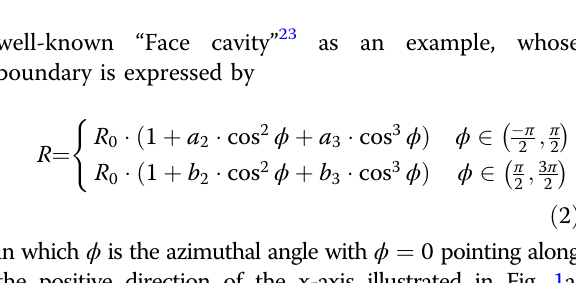
Fig. 1 Ray dynamics of topologically curved microcavities. a Schematic picture of the microcavity. O and O ’ are the center of the spherical surface and the geometric center of the cavity, respectively. ROC: radius of curvature; ROB: radius of the boundary. b Light trajectories of a symmetric circular cavity with ROB = 0.8 de fi ned on a curved surface of ROC = 1. c sin χ ( χ is the re fl ecting angle) of the N-period modes as a function of the effective curvature k = ROB/ROC in a symmetric circular microcavity. d Calculated resonant frequencies for the 3-period (red) and 4-period (blue) modes as a function of k in a symmetric circular microcavity. e , f The PSOS of a Face cavity de fi ned on a curved surface with k = π /6 ( e ) and on a fl at surface ( f ). The dashed horizontal lines label the bottoms of the higher islands in the 3-period and the 4-period groups, which correspond to identical structural positions in the PSOSs of e , f , showing a discrepancy in the height of sin